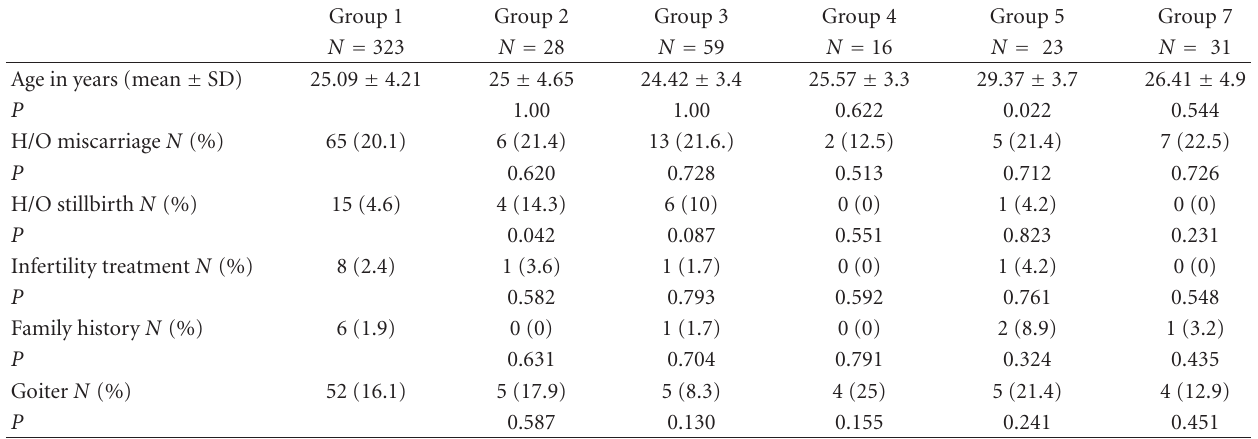
Table 1: Baseline clinical characteristics in di ff erent groups and comparison to subjects with group 1 ∗ .